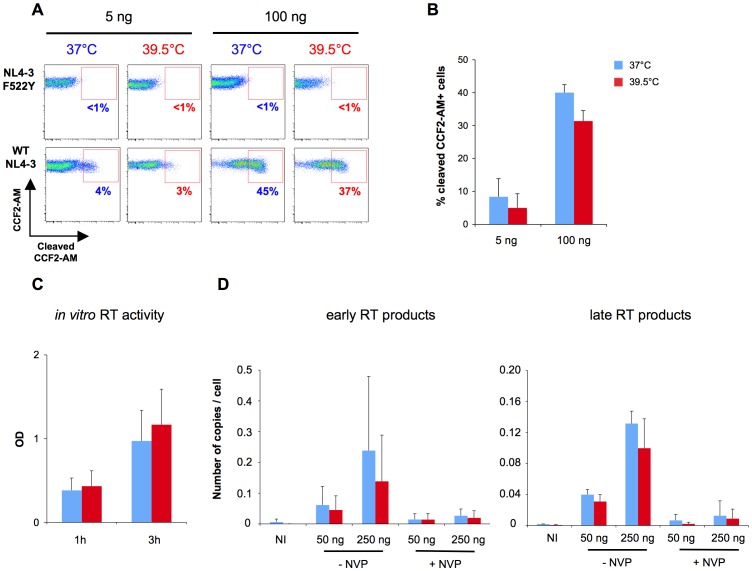
Hyperthermia does not stimulate viral fusion and reverse transcription.A: Viral fusion assay. One representative experiment is shown. Jurkat cells were exposed for 2 hours at 37°C or 39.5°C to 5 or 100 ng Gag p24/105 cells/0.1 mL of either WT, or a non fusogenic env mutant (F552Y) NL4-3, both bearing the chimeric protein β-lactamase-Vpr. Viral access to the cytoplasm was assessed by flow cytometry, using the ability of β-lactamase to cleave CCF2-AM, a fluorogenic substrate. B: Mean ± SD of 3 independent experiments. C: In vitro assessment of RT activity. Mean ± SD of 2 independent experiments is shown. HIV-1 NL4-3 virions were lysed and incubated at 37°C or 39.5°C for 1 h or 3 h. RT activity was measured with the Innovagen RetroSys RT Activity Kit (405 nm OD). D: Viral DNA synthesis in Jurkat cells. Mean ± SD of 3 independent experiments is shown. Jurkat cells were infected with 50 ng or 250 ng Gag p24 of Δenv(VSV)//mL/106 cells for 2 hours at 37°C or 39.5°C, washed, and grown at 37°C or 39.5°C. 8 hours p.i., cells were harvested and viral DNA was measured by quantitative PCR. As a control, the RT inhibitor nevirapine (NVP) was added during infection.